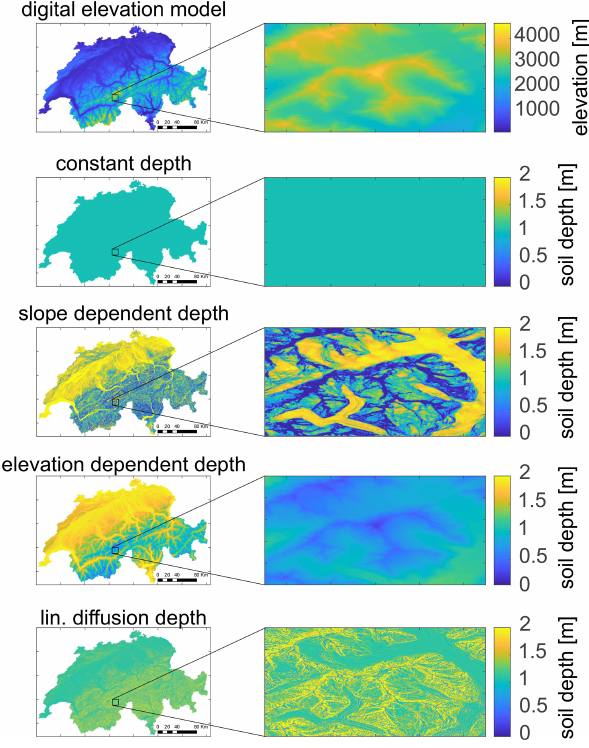
Figure 2. From top to bottom: digital elevation model (DEM, Swis- stopo 25m) and four soil depth distributions: constant ( d = 1m), slope- and elevation-dependent, and d between 0 and 2m assum- ing the linear diffusion model at steady state. The maps on the right show a zoom-in view to the same area to appreciate small-scale variability.